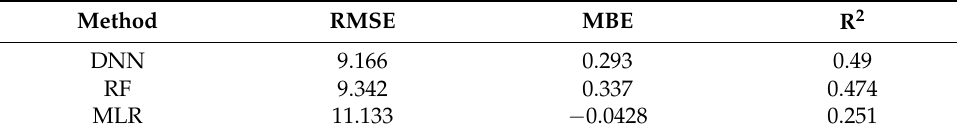
Figure 3. Scatterplots describing correlations between ground-truth PM 2.5 measurements and estimated PM 2.5 values calculated by each model: ( a ) DNN; ( b ) RF; ( c ) MLR; and ( d ) CMAQ. Table 2. Summary of the DNN, RF, and MLR cross-validation